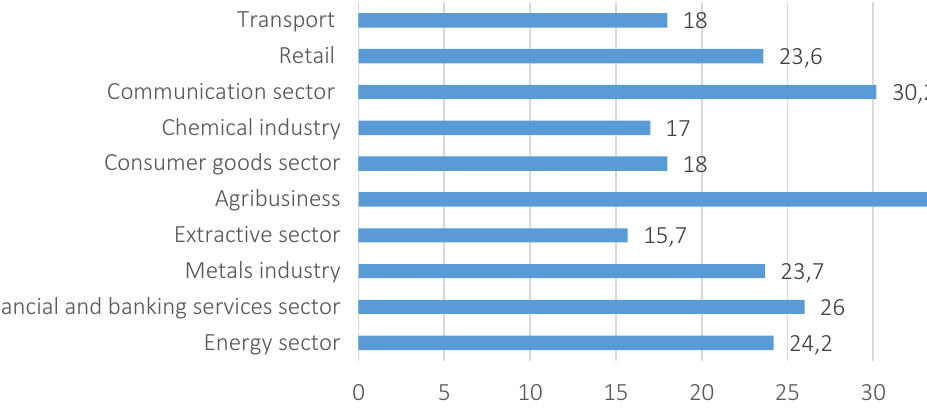
Figure 1. Sector analysis of website